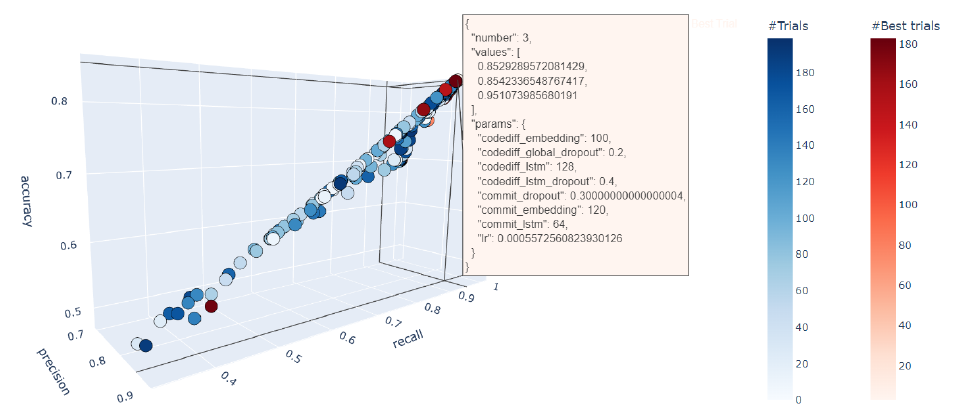
Figure 4. The hyperparameters tuning trials in the three-dimensional